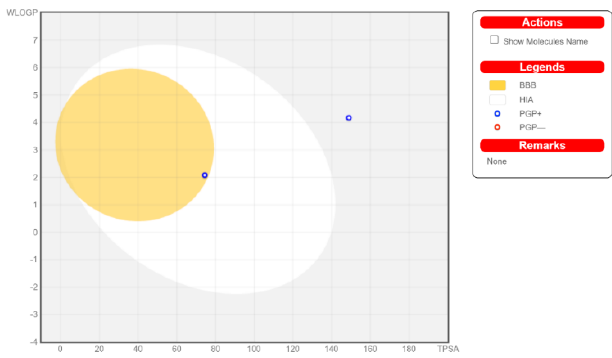
Figure 11. Predicted biological targets of 3 (left) and 4 (right).